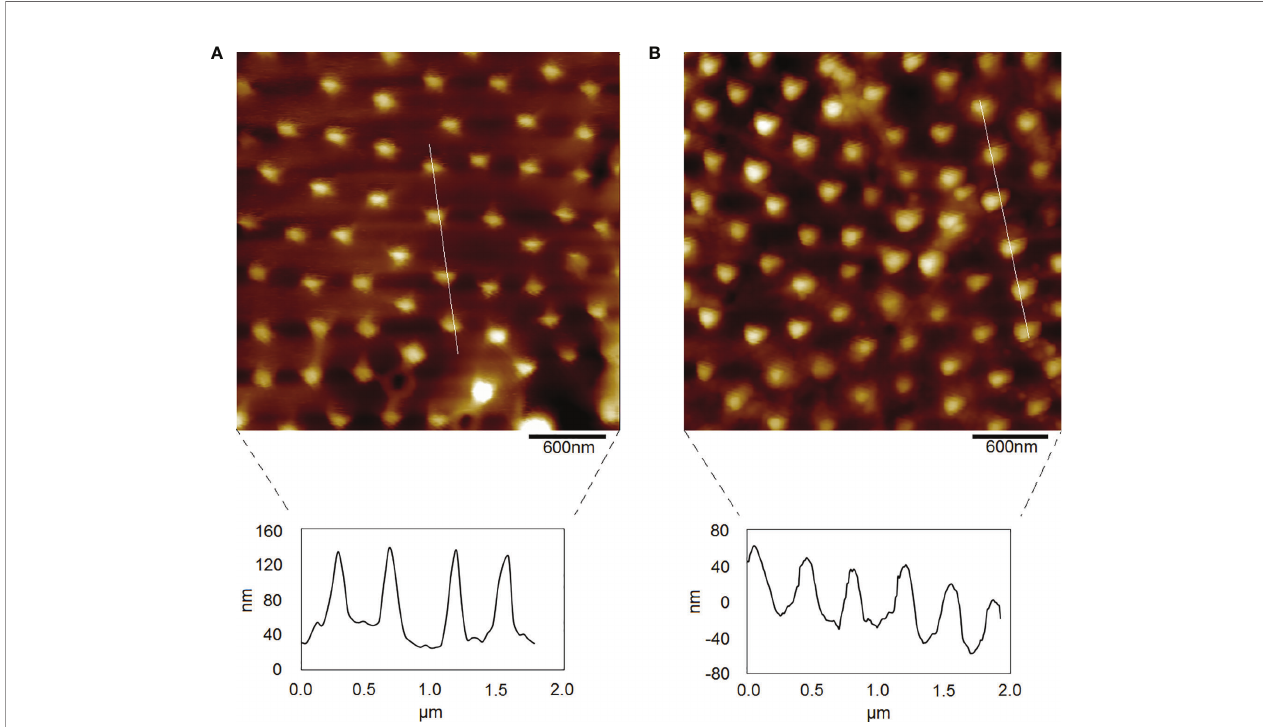
FIGURE 4 | Morphology of P. donghaiense by AFM. (A) The normal culture condition. (B) The nitrogen limiting condition.